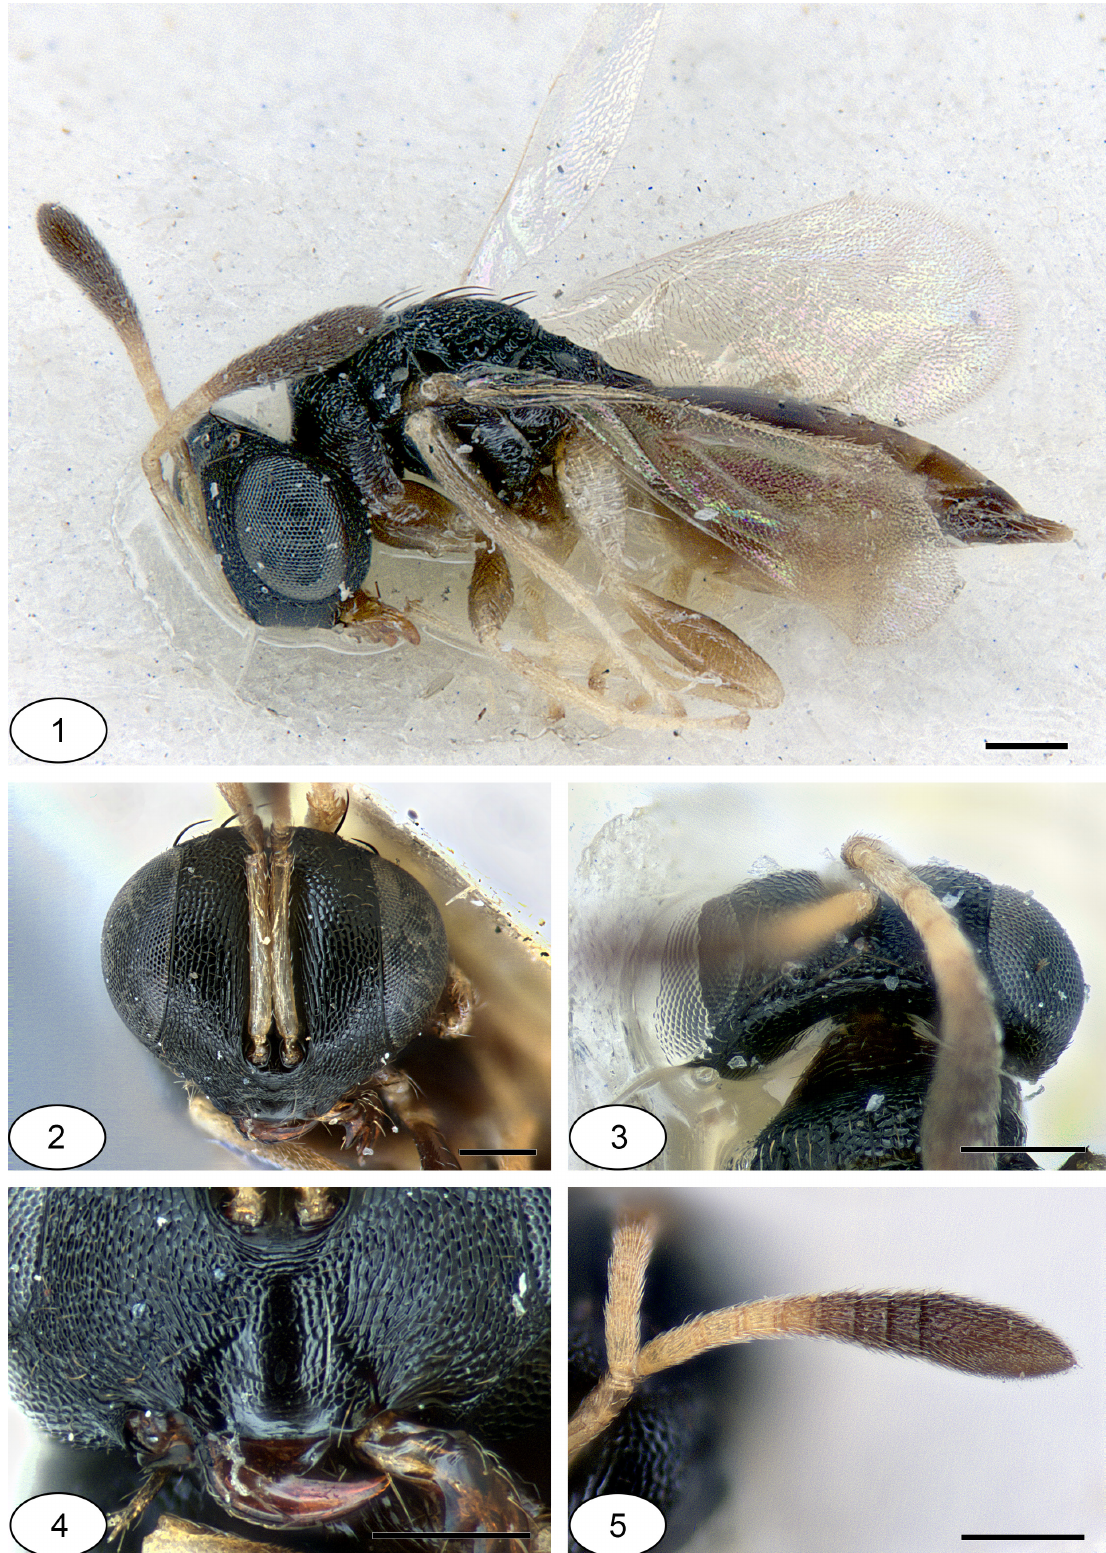
Figs 1–5. Netomocera africana Hedqvist, 1971. 1 . Paratype, ♀, habitus, lateral view. 2 . ♀, head, frontal view. 3 . Paratype, ♀, head, dorsal view. 4 . ♀, lower face. 5 . Paratype, ♀, antenna. Scale bars: 0.2